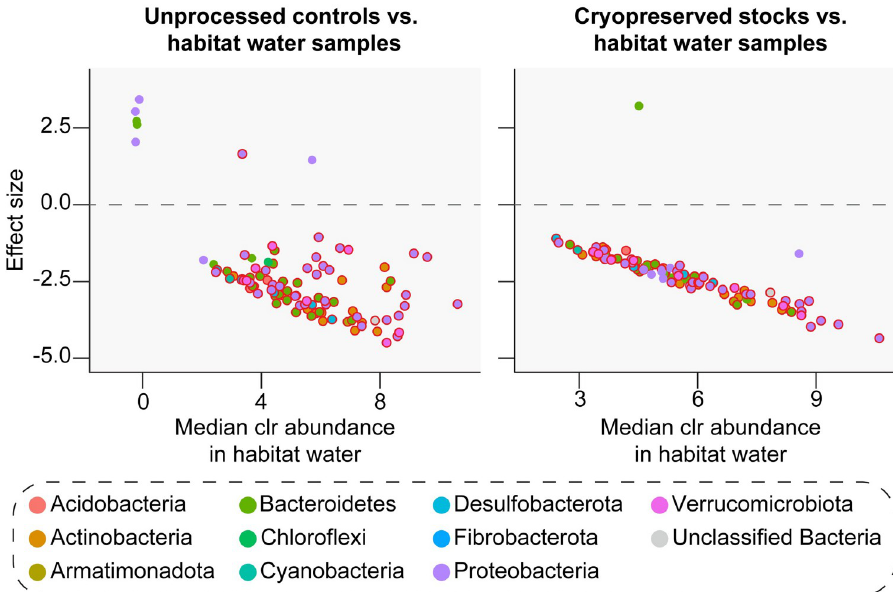
material from cryopreserved